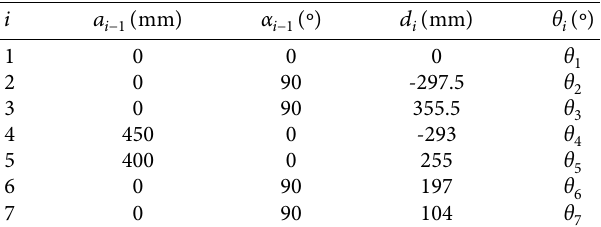
Figure 1: Schematic diagram of the 7-DOF redundant robot. Table 1: Improved D-H parameters of the 7-DOF redundant robot.